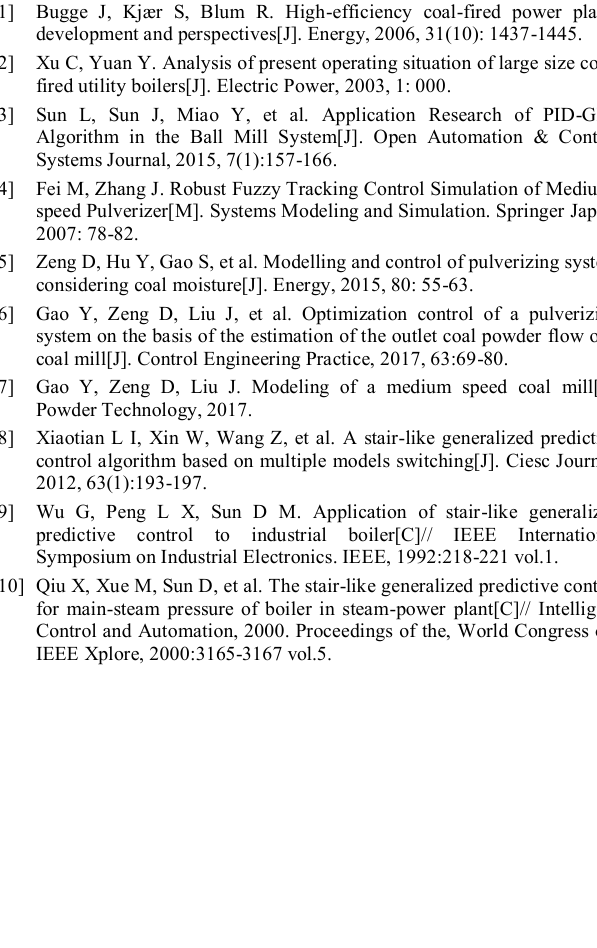
Fig.4 Curve for controlled variables